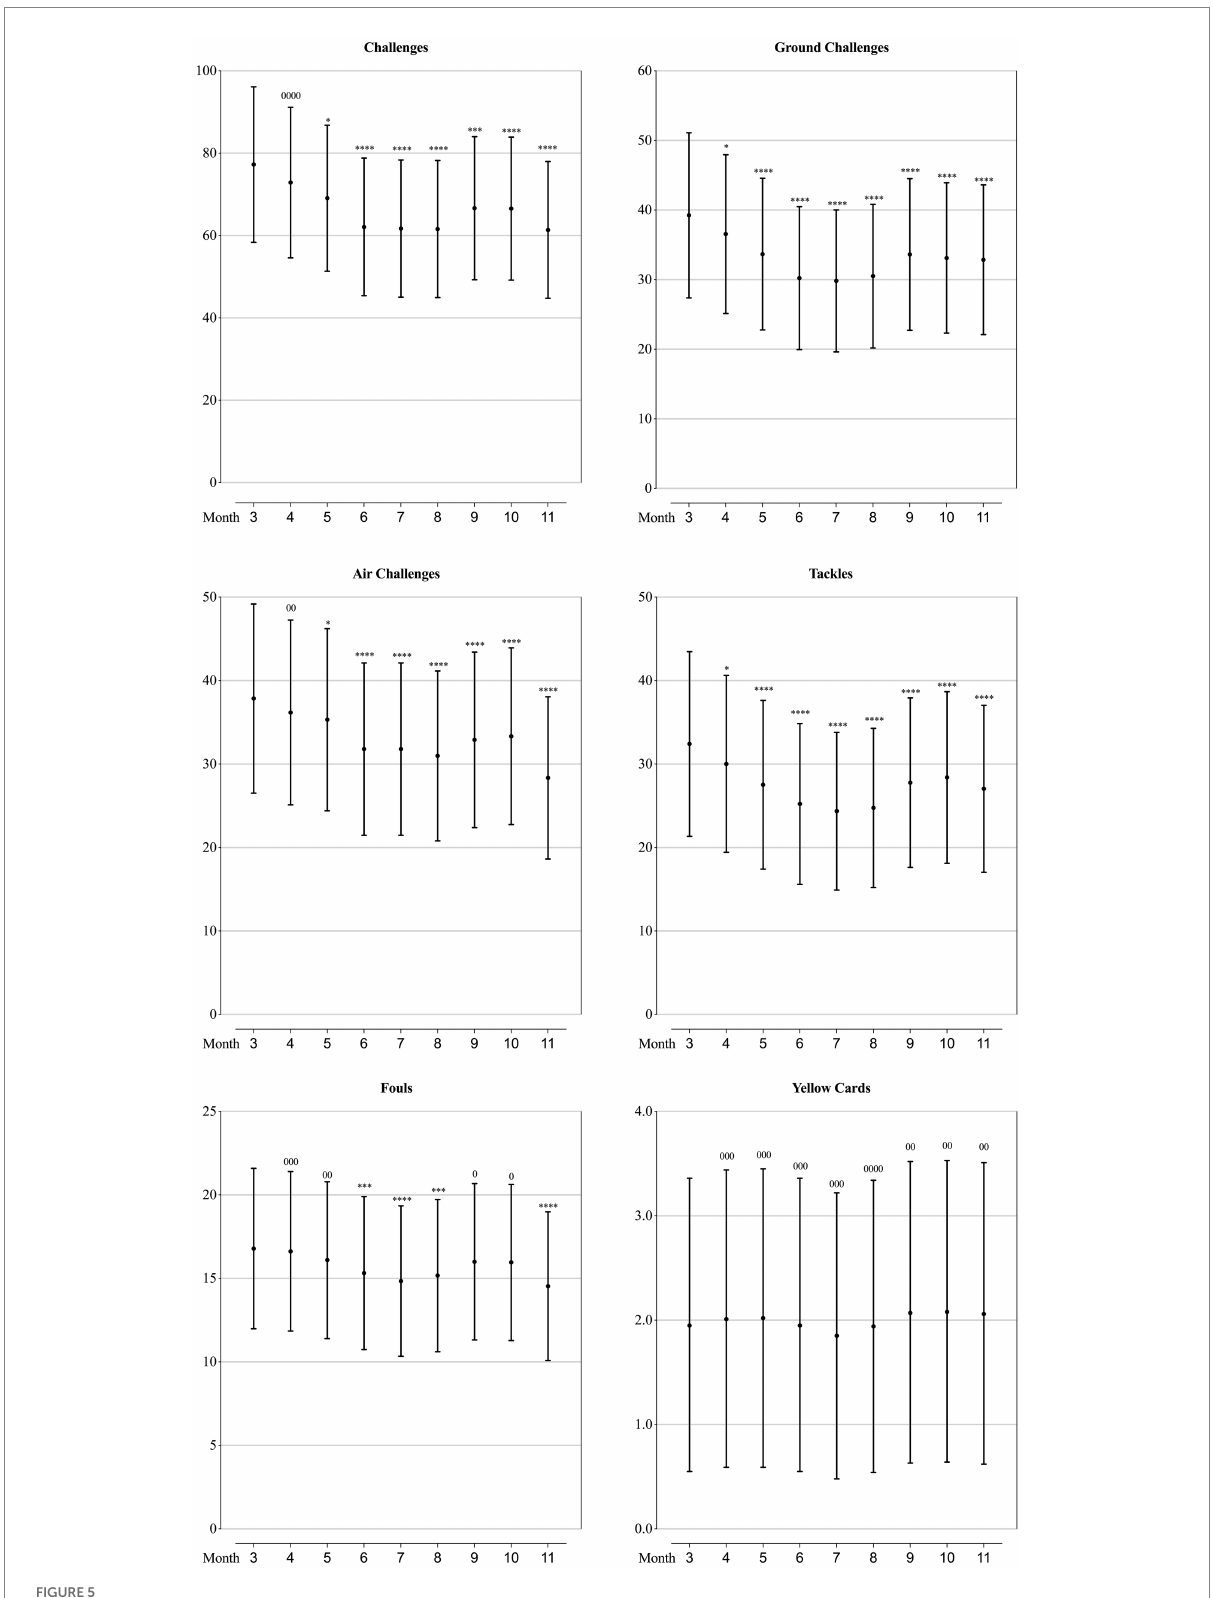
FIGURE 5 Values of defending-related parameters in each month of a season for the teams competing in the CSL in 2012-2019 estimated from the generalised mixed linear modelling. Filled dots are the means. Error bars are the standard deviations. Symbols “0” and “*” stands for trivial and negative change from the value of March (month “3”). Number of symbols indicate the likelihood for the magnitude of the true effect as follows: 1-possible; 2-likely; 3-very likely; 4-most